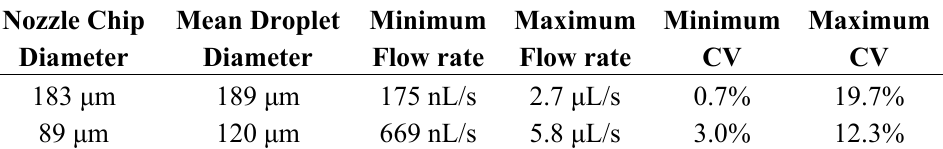
Table 2. Calculated flow rate and coefficient of variation (CV) according to measurements depicted in Figures 9 and 10.